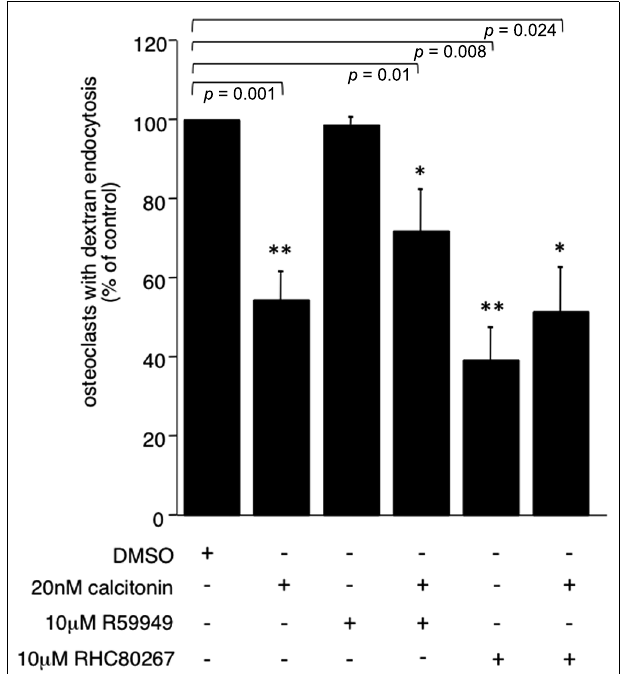
FIGURE 3 | PUFA are important for endocytic trafficking. Rabbit osteoclasts plated on dentine were incubated for 16 h before a 15 min pre-incubation with either the DAG kinase inhibitor R55949 or the DAG lipase inhibitor RHC 80267 (both 10 μ M) before the addition of 20 nM calcitonin for 30 min.TRITC-dextran 3,000 was then added for 5 min before fixation.The number of osteoclasts presenting endocytosed dextran was counted after immunodecoration with antibodies directed against the α v β 3 integrin and expressed as percentage of total. Columns show mean percentage of osteoclasts with dextran endocytosis and standard deviation. Results are average of two independent experiments. Significant reductions in dextran endocytosis are marked: * p < 0.05, ** p < 0.005, individual p -values are shown above the